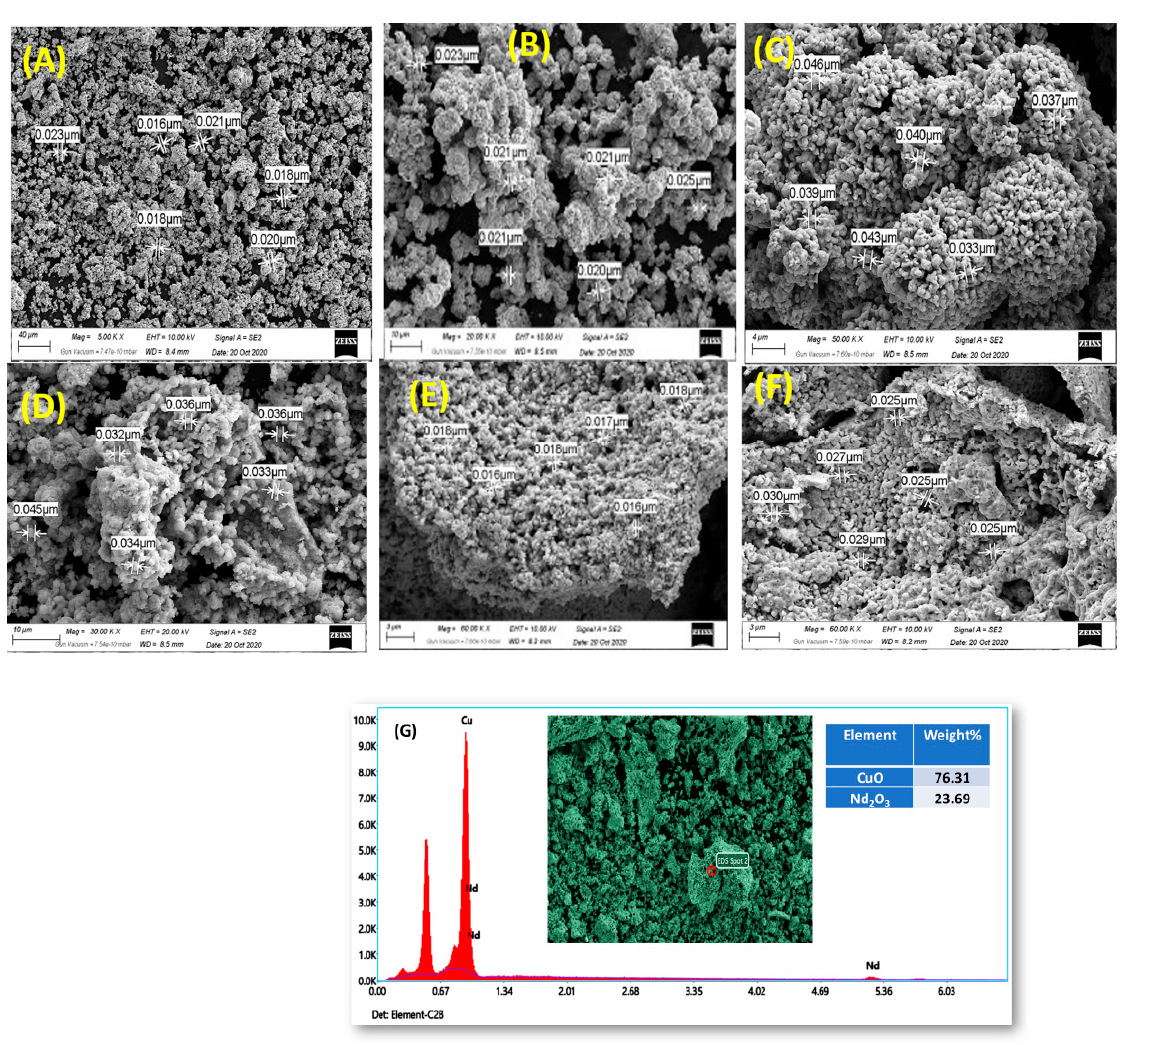
Figure 3. ( A – F ): FE-SEM images of pure CuO and Nd 2 O 3 doped CuO nanostructured samples, ( G ) EDAX spectrum of 7.5% Nd 2 O 3 doped CuO nanostructured sample. EDX image depicts the peaks of CuO and Nd 2 O 3 beside atomic percentage of ele- ments (see inset of Figure 3G) contained in 7.5% Nd 2 O 3 doped CuO nanoparticle, where it verified the production of Nd 2 O 3 doped CuO nanoparticle by homogeneous chemical structure. 3.3. DLS of Nanostructured Nd 2 O 3 Doped CuO Figure 4a,b depicts the average ζ av and conductivity obtained from % Nd 2 O 3 doped CuO nanoparticles. As shown in Figure 4a, ζ av -potential increased by increasing percent- age Nd till 7.5% Nd 2 O 3 doped CuO nanoparticle reaching ~27 mV, which it can attribute to the deformation in the CuO crystal lattice by increasing content of Nd 2 O 3 . Figure 4b depicts the conductivity enhancement by increasing Nd 2 O 3 content, which was 0.025 mS/cm at 7.5% Nd 2 O 3 doped CuO nanoparticle. Enhancement of conductivity can be